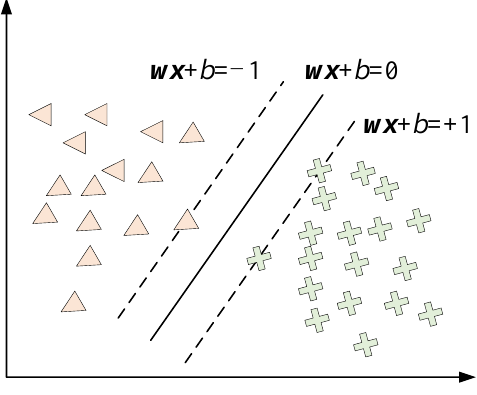
Figure 4. SVM model.